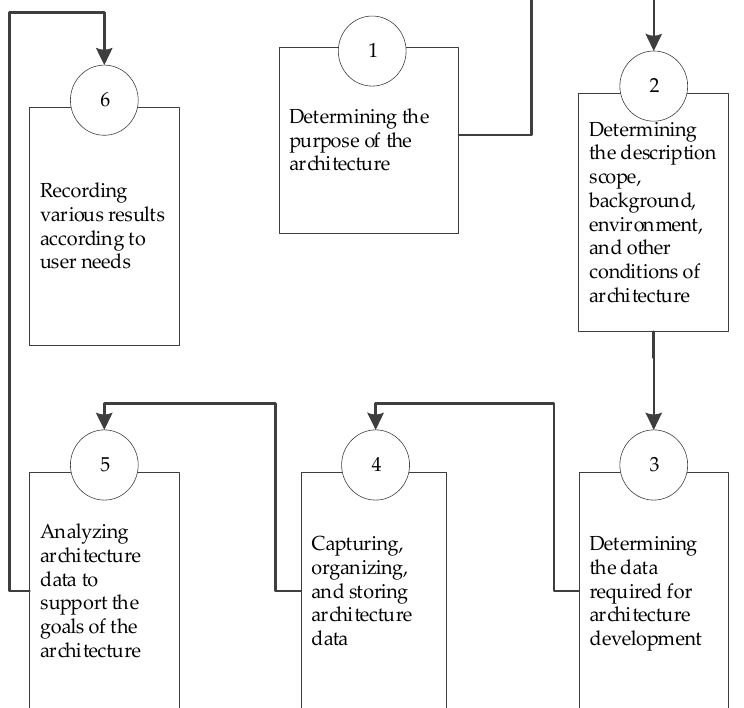
Figure 3. Data as a Center (DaaC) Architecture development process.